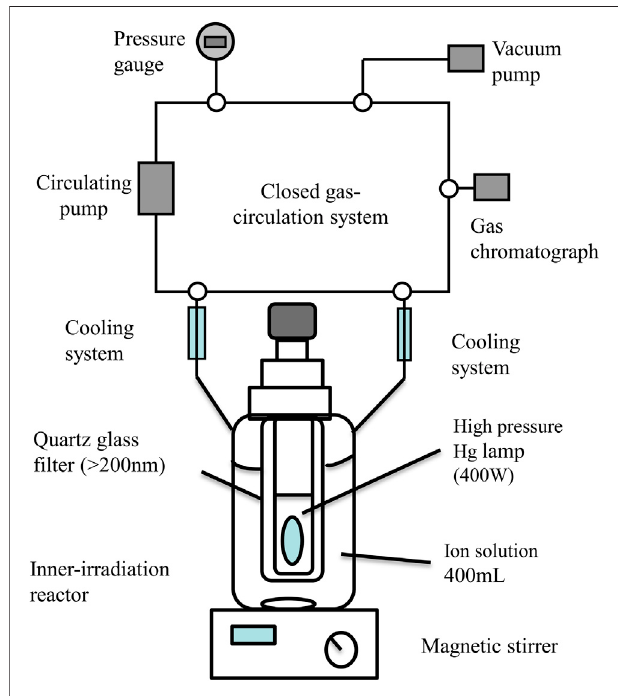
FIGURE 1 | Schematic diagram of hydrogen generation set-up working at negative